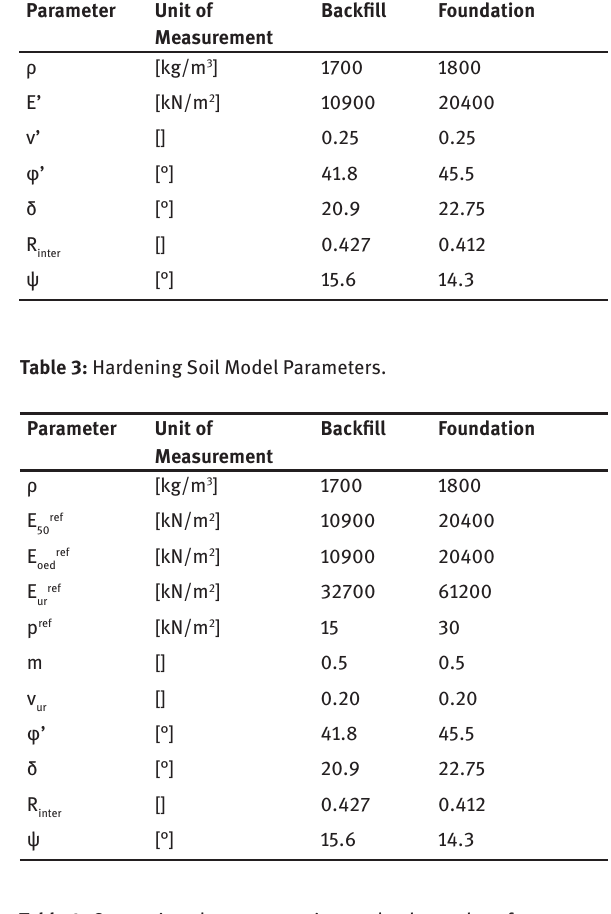
Table 4: Comparison between maximum absolute values for prototype and scaled